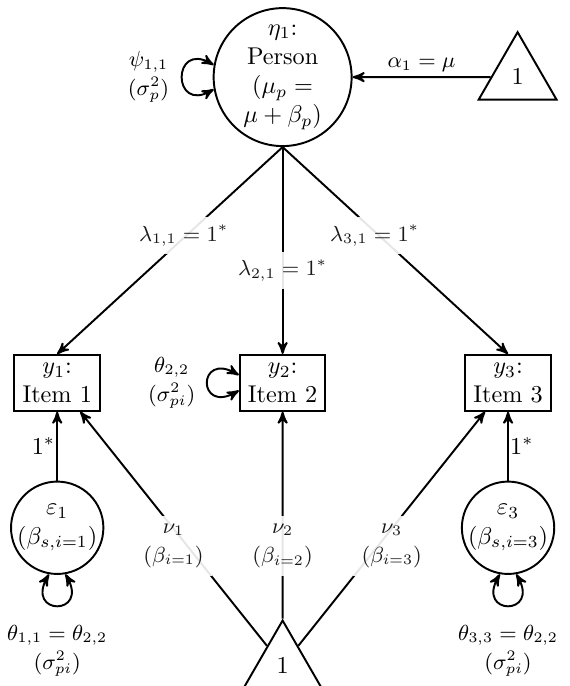
Figure 1. Path diagram depicting p × i GT model represented as a CFA with 3 indicators (items) as the facet of generalization. Each CFA variable and parameter are labeled using traditional LISREL notation, accompanied by GT notation in parentheses. The unique-factor variances are constrained to equality, the item intercepts are constrained to average zero to identify the factor mean (grand mean µ from GT), and the variance of intercepts represents the variance component σ 2 of items). The unique factor for Item 2 is omitted for clarity, and its variance is instead depicted with a double-headed arrow pointing to Item 2